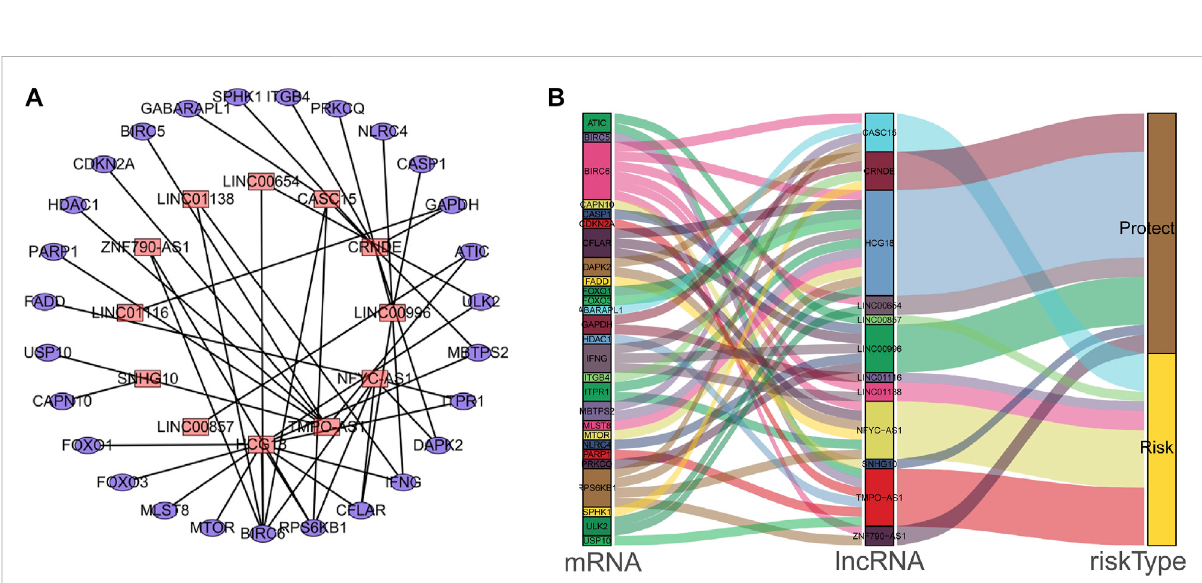
FIGURE 5 The interaction network of autophagy genes and OS-associated lncRNAs in LUAD patients. (A) The co-expression network of the autophagy- related mRNAs and lncRNAs was constructed and visualized using Cytoscape. (B) The co-expression network with risk-type information was visualized using the Sankey